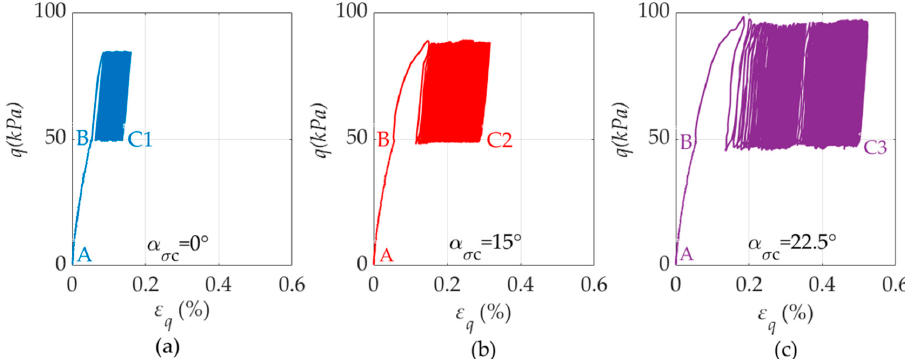
Figure 10. Deviatoric stress versus deviatoric strain trends for ( a ) Test 1, α σ c = 0°; ( b ) Test 2, α σ c = 15°; and ( c ) Test 3, α σ c = 22.5°.